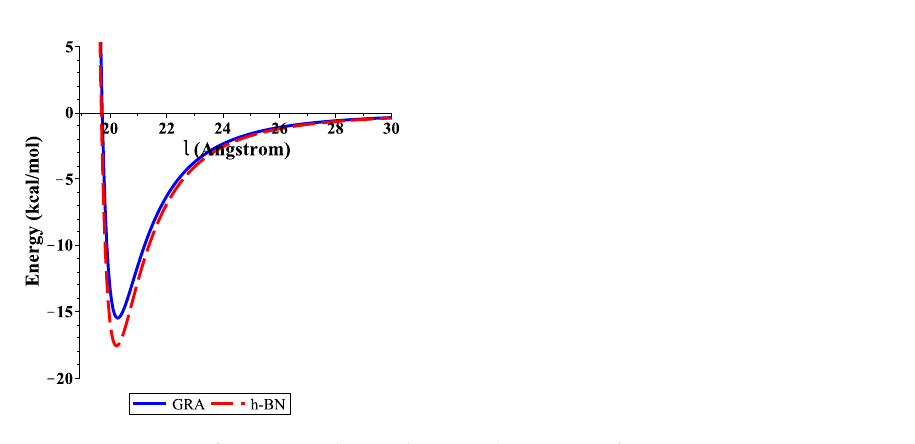
Figure 3. Energies of ssDNA and nanosheets with respect to l . Table 1. Values of the constants utilised in this study.